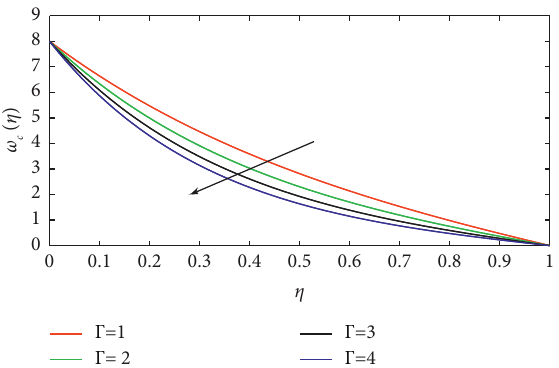
Figure 20: Concentration profles for the diferent values of Γ . Table 1: Skin-friction coefcient for various values of